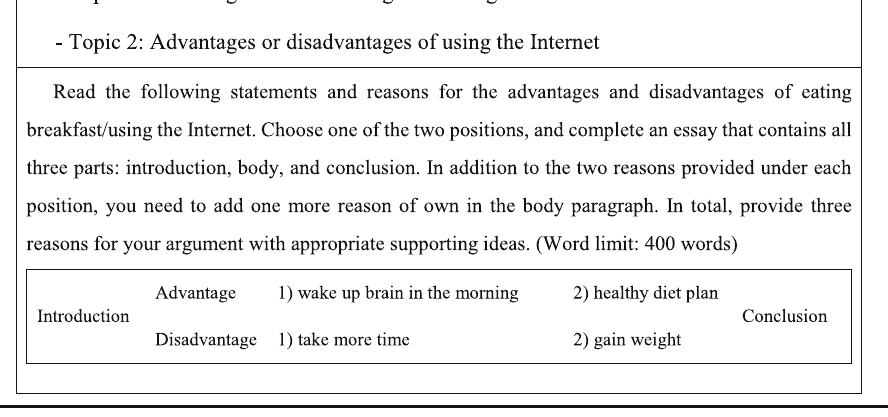
Table 1 Writing topics and a sample